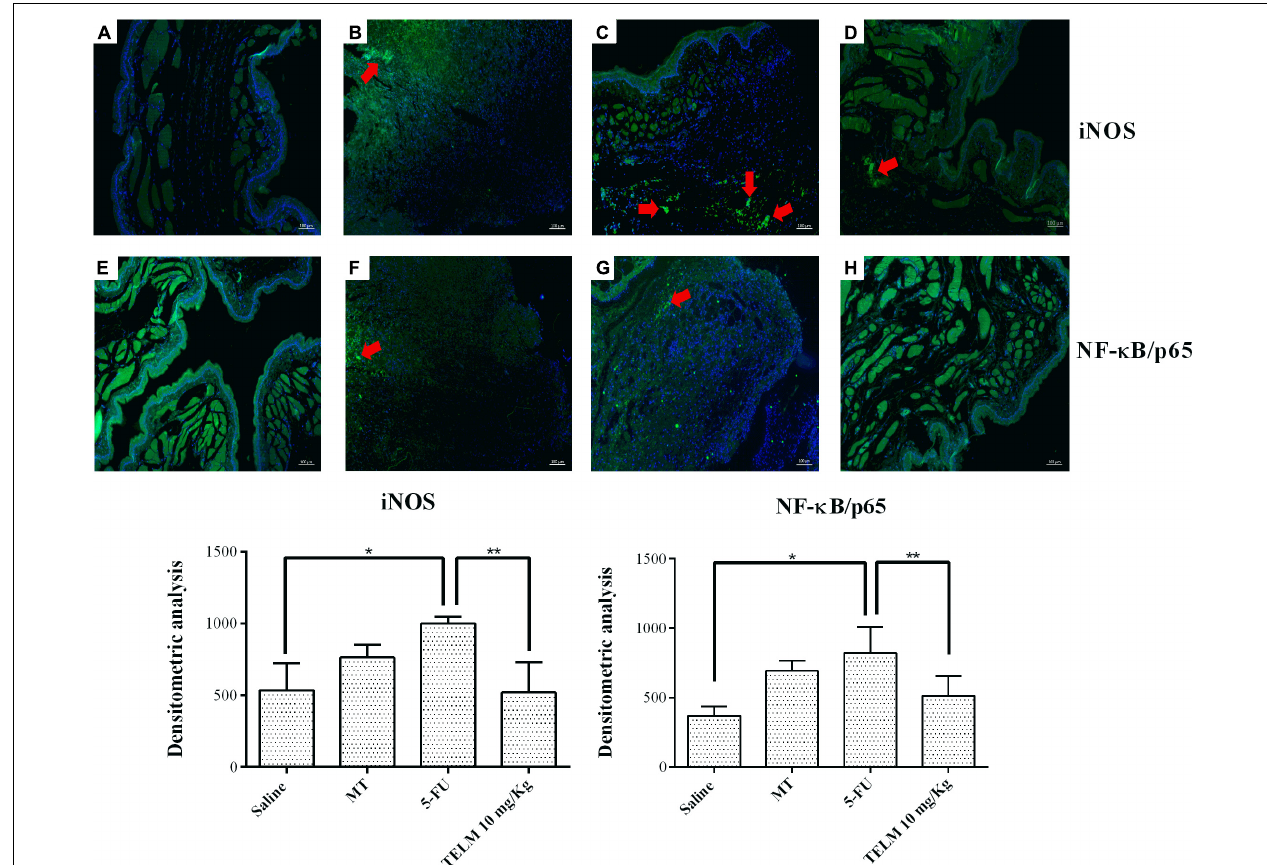
FIGURE 7 | Immunofluorescence for iNOS; NF κ B p65 and mean of the densitometric analysis. The 5-fluorouracil (5-FU) group (C , G) had higher green labeling than that of the mechanical trauma (MT) group (B , F) or the saline group (A , E) ( p < 0.05; n = 5). The TELM 10 mg/kg group (D , H) had a reduced immunoreactivity compared to the 5-FU group ( n = 5; ∗ p < 0.05 vs. the saline group, ∗∗ p < 0.05 vs. the 5-FU group (analysis of variance with Tukey’s